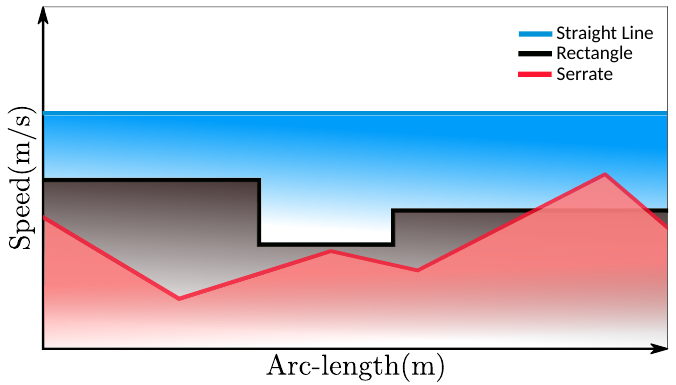
Figure 3. Different shapes of path